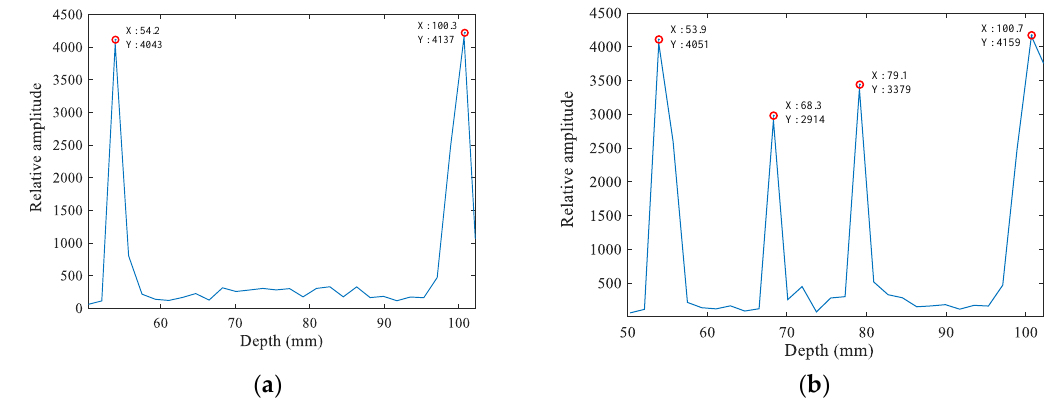
Figure 10. Results of accuracy measurement of mfMAET-CPS: ( a ) two interfaces detected by mfMAET-CPS; and ( b ) four interfaces detected by mfMAET-CPS.